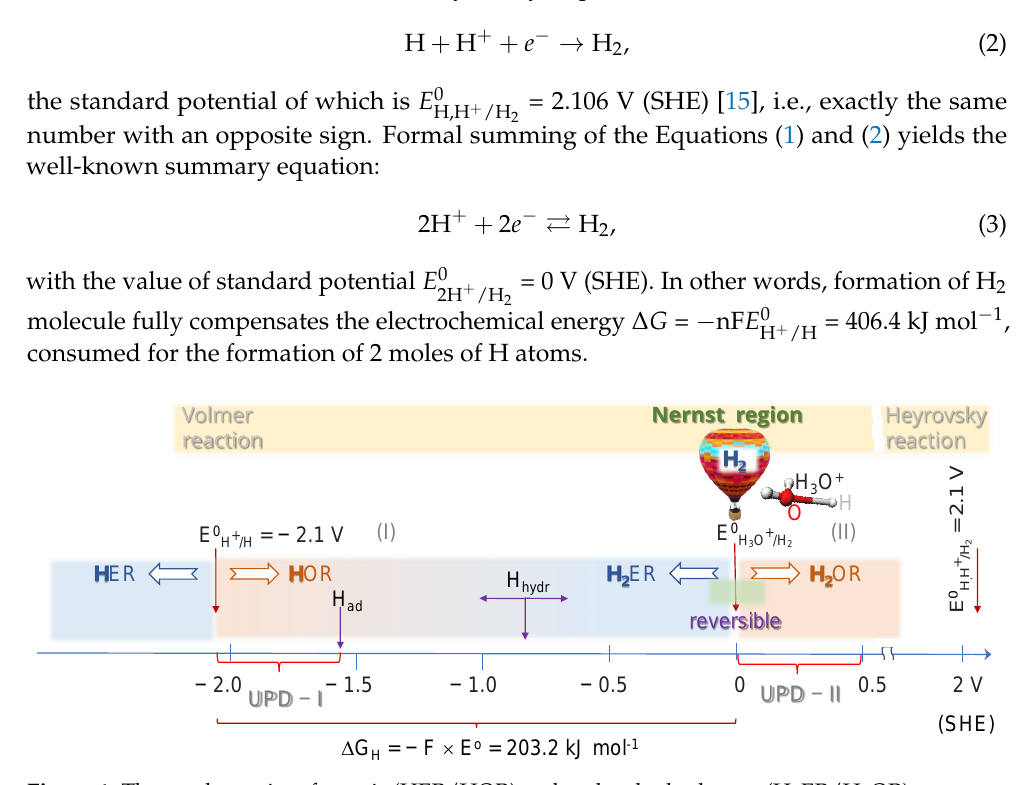
Figure 1. Thermodynamics of atomic (HER/HOR) and molecular hydrogen (H 2 ER/H 2 OR) processes in the potential range between Volmer and Heyrovsky reactions. The underpotential deposition regions UPD-I and UPD-II correspond to adsorption of H ad and H 3 O + /H + , respectively. The width 2 of regions was evaluated on the basis of 50 kJ mol − 1 , which is the energy of hydrogen adsorption on Pt reported in the literature [3]. H hydr stands for surface hydrides, formation of which can depolarize the discharge of H + . The molecular hydrogen evolution and oxidation reactions (H 2 ER/H 2 OR) are reversible on a Pt electrode in the vicinity of 0 V denoted as Nernst